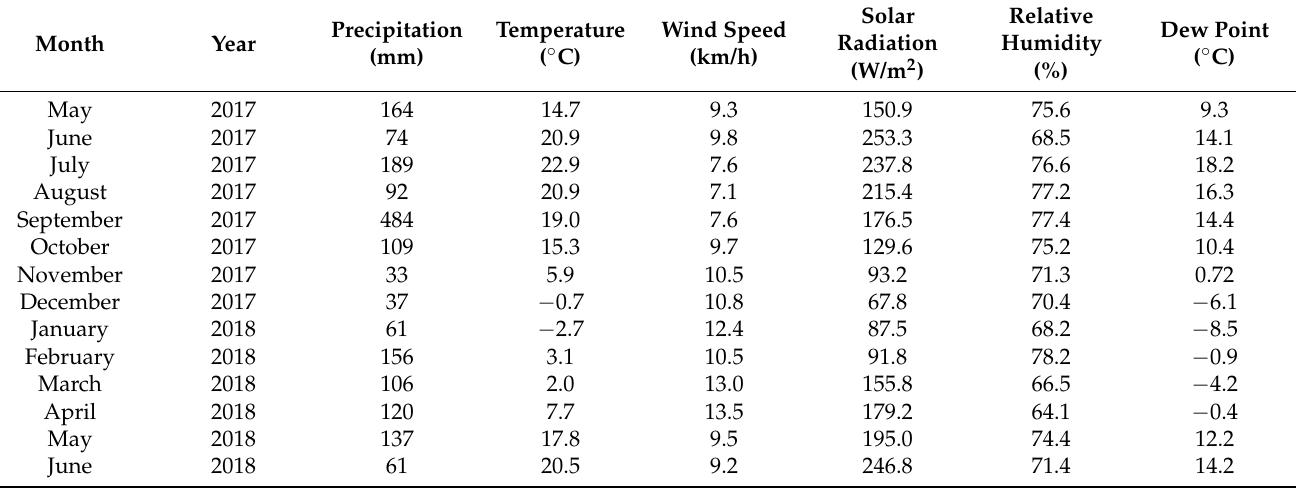
Table 4. Monthly averages of weather variables in Pittstown, NJ, USA from May 2017 to June 2018. Source: